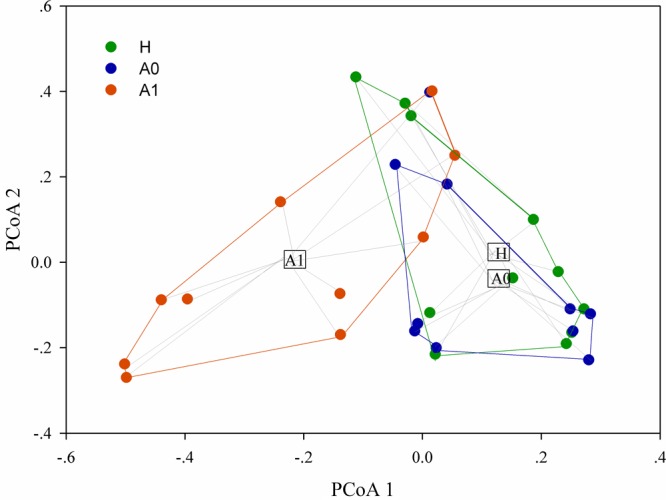
Principal coordinates analysis (PCoA) ordination (operational taxonomic units = 97% 16S rRNA sequence similarity) showing distinctly different microbial composition between CRC patients and healthy individuals based on the Bray-Curtis dissimilarity matrix.